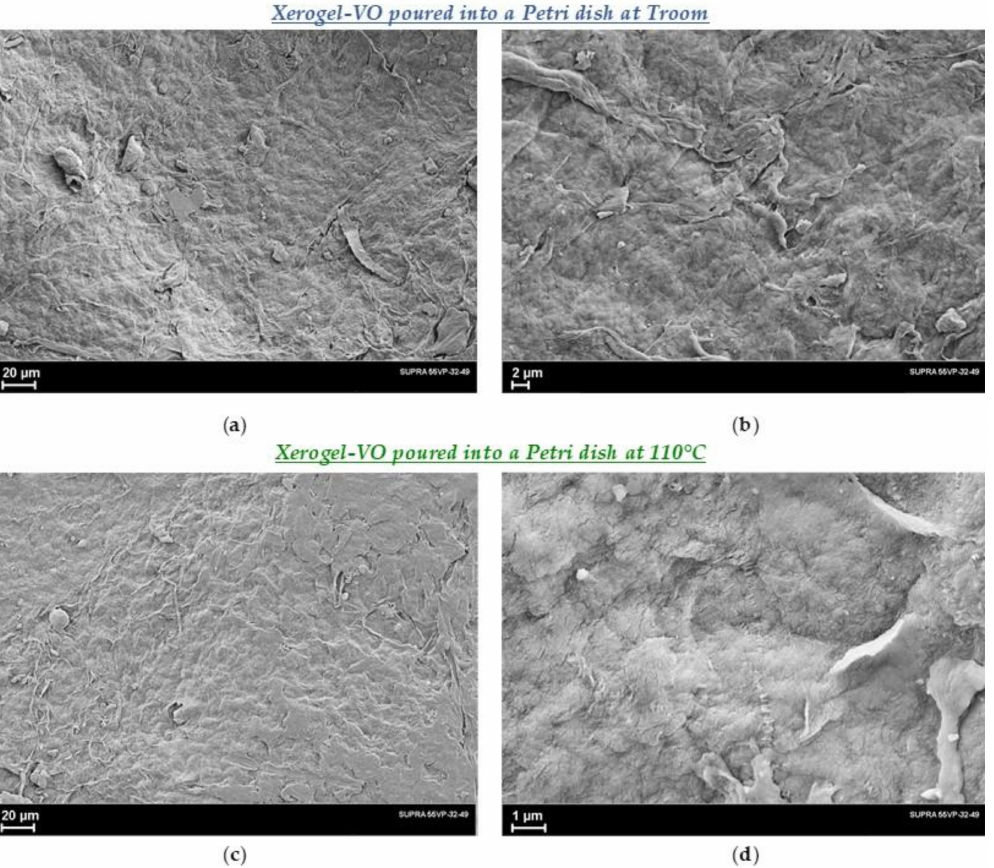
Figure 5. SEM images of the xerogel-VO obtained from a 1.5% solution in vaseline oil: ( a , b )—poured into a Petri dish at T room , or ( c , d )—poured into a Petri dish at 110 ◦ C, then cooled to T room , removed excess oil under pressure, and after that washed off the oil in hexane.